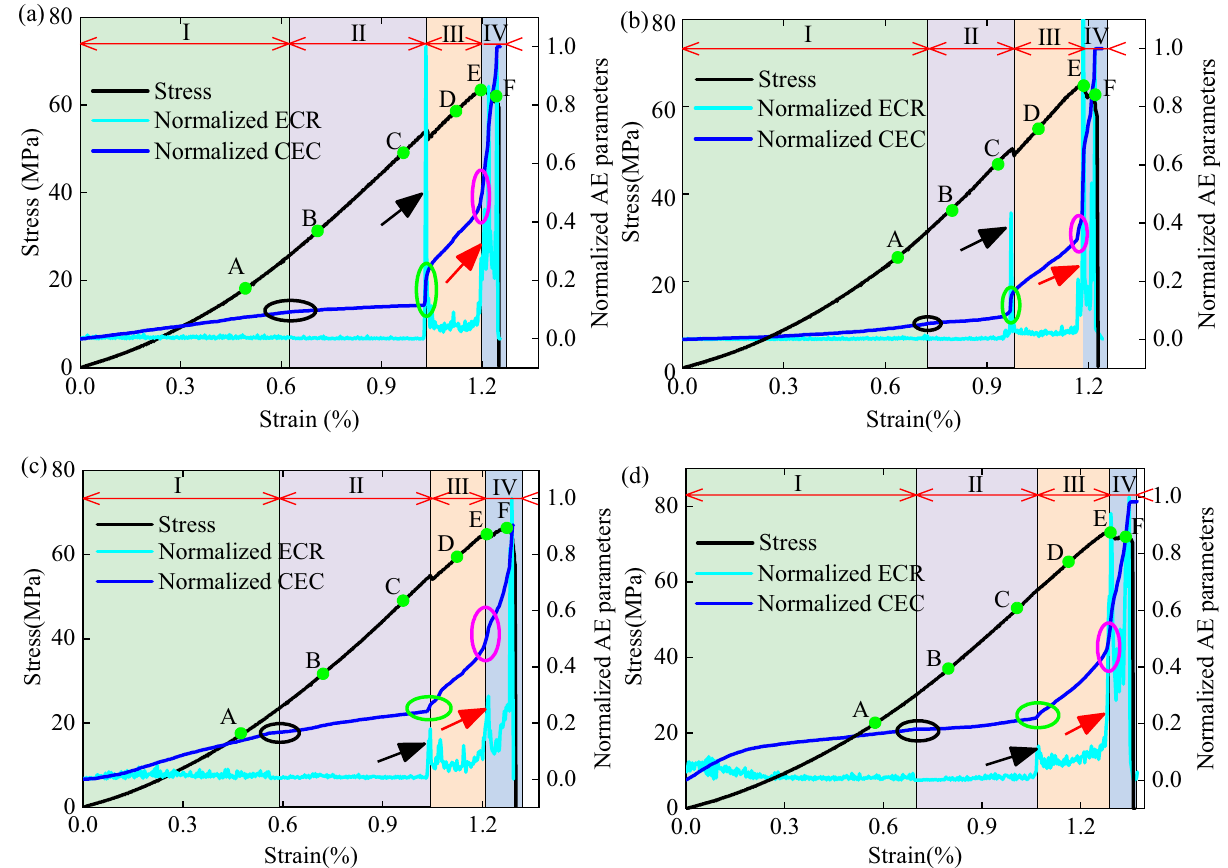
Figure 6. Normalized AE parameters and damage evolution stages for ( a ) Specimen No. 0-1, ( b ) Specimen No. 30-1, ( c ) Specimen No. 45-1, and ( d ) Specimen No.